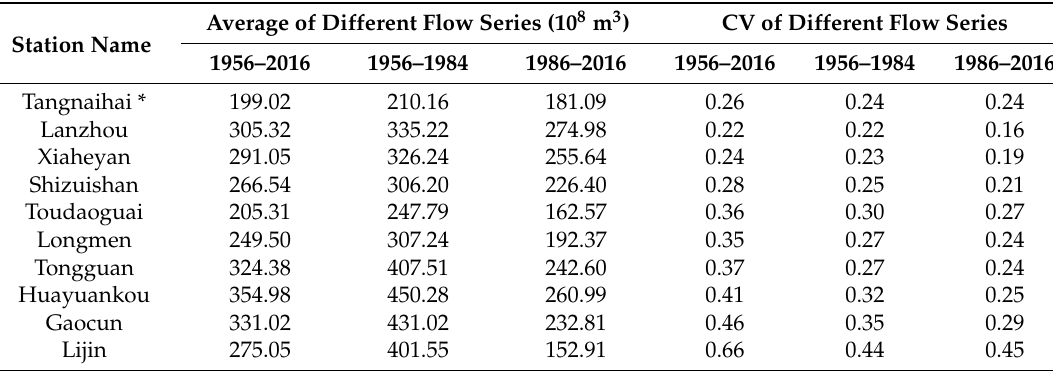
Table 3. Average and CV of different flow time series along the Yellow